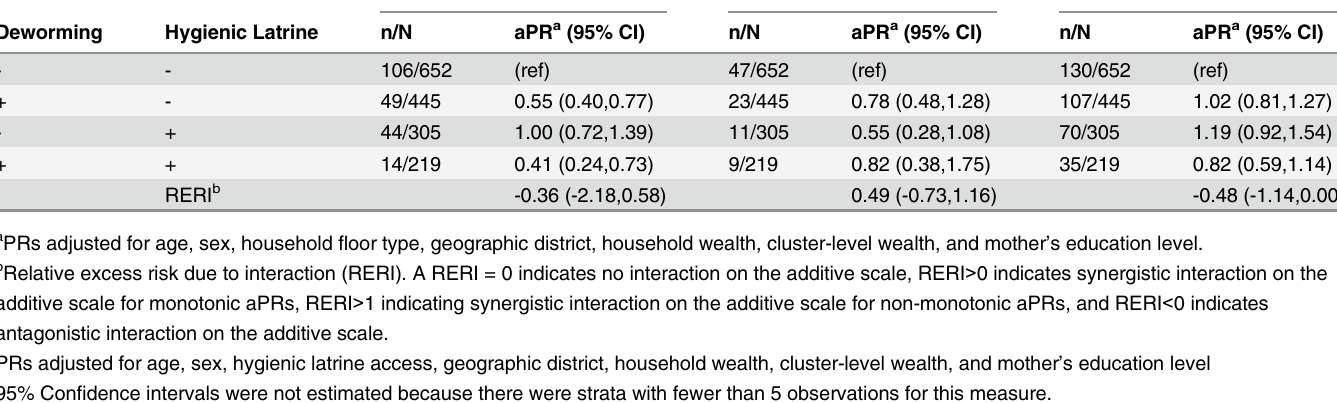
Table 3. Adjusted prevalence ratios for single and combined deworming and hygienic latrine access and relative excess risk due to interaction.